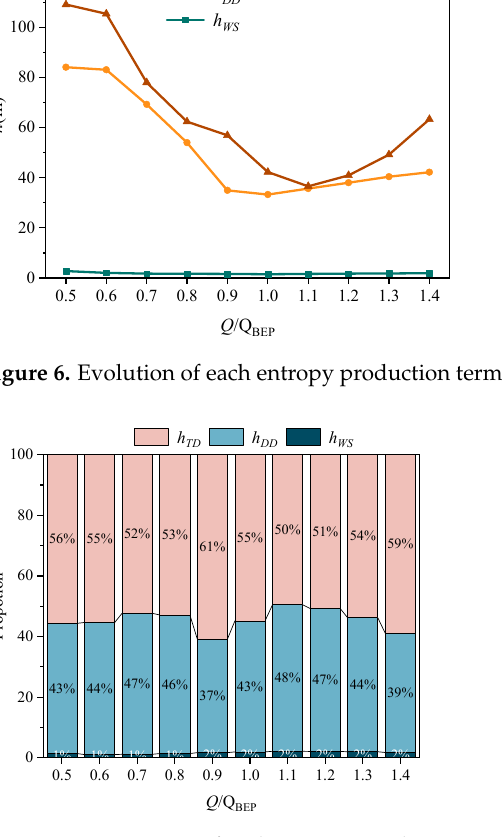
Figure 7. Proportions of each entropy production term under various operating points.